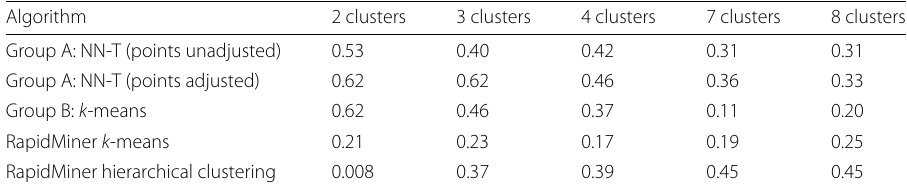
Table 2 Recorded silhouette